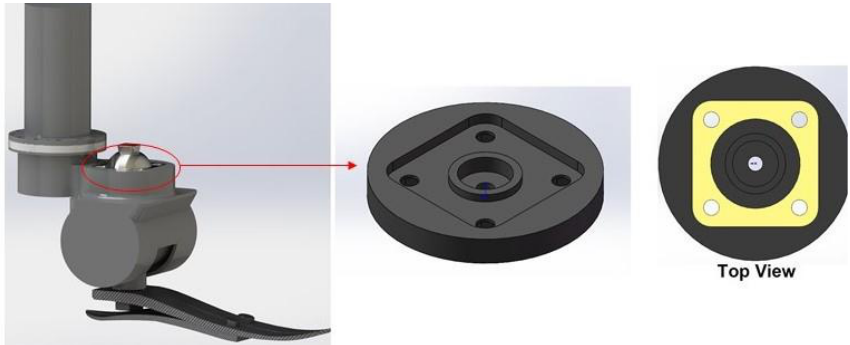
Figure 6. 3D model of 3D-printed supporting part.